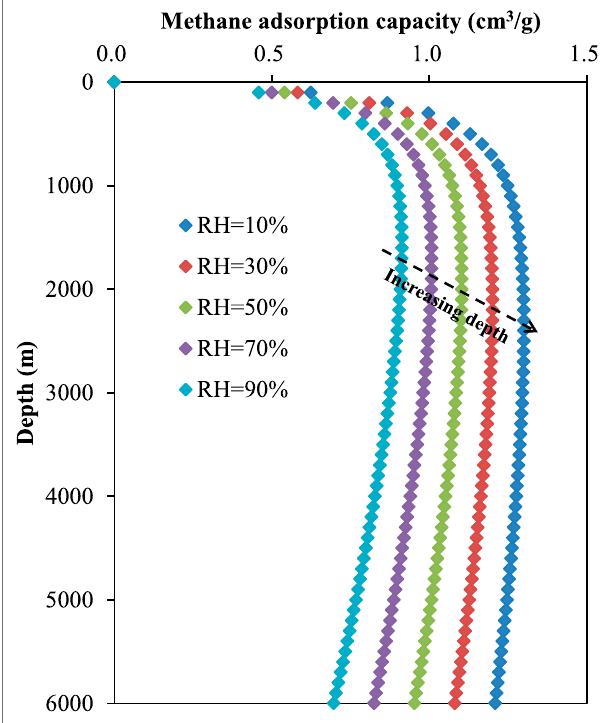
FIGURE4| Methaneadsorptioncapacityofshaleasafunctionofdepth.